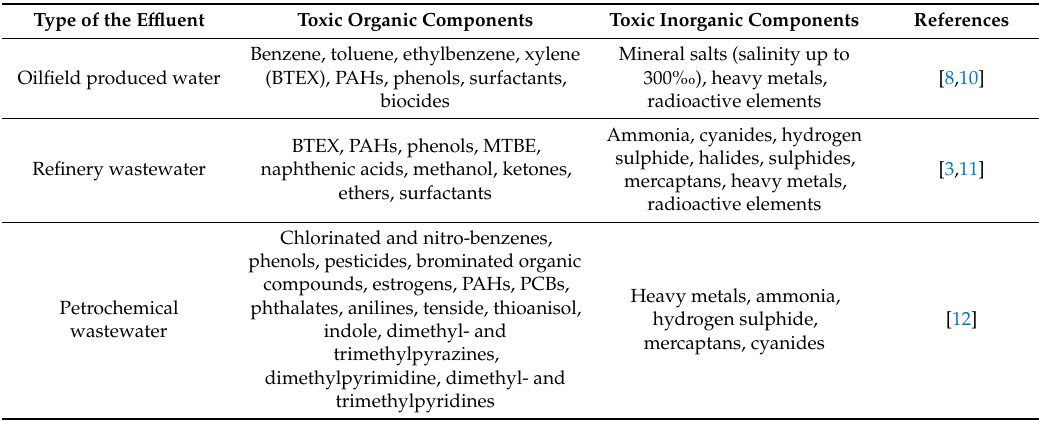
Table 1. Toxic Organic and Inorganic Compounds Present in Major Hydrocarbon-Containing Wastewater